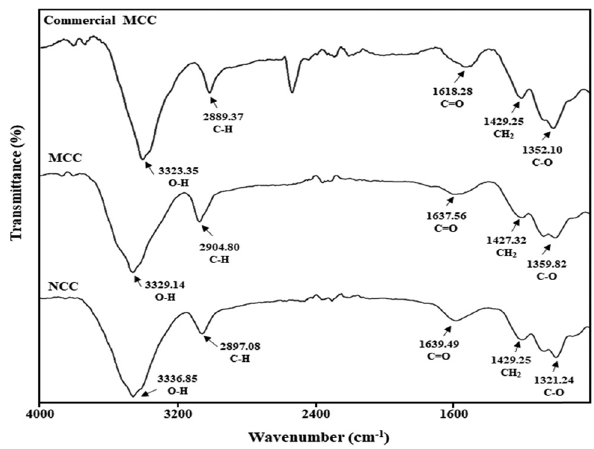
Figure 5: Fourier transform infrared spectra of commercial MCC, MCC, and NCC samples.